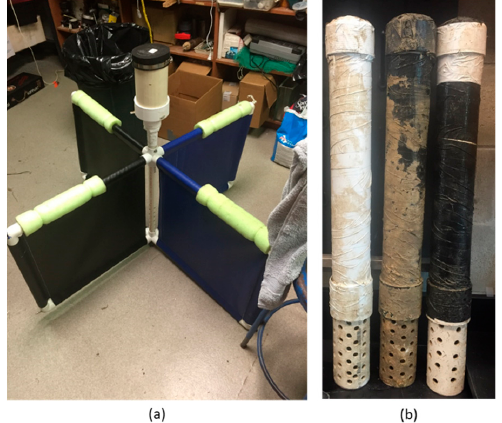
Figure 4. Picture of the deployment housing for ( a ) the drifter application and ( b ) the moored